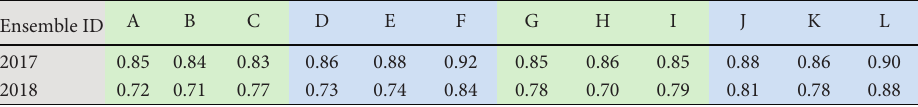
Table 2: FSS of ensemble members for the wet seasons in 2017 and 2018 (simulations with KF in green and BMJ in blue).